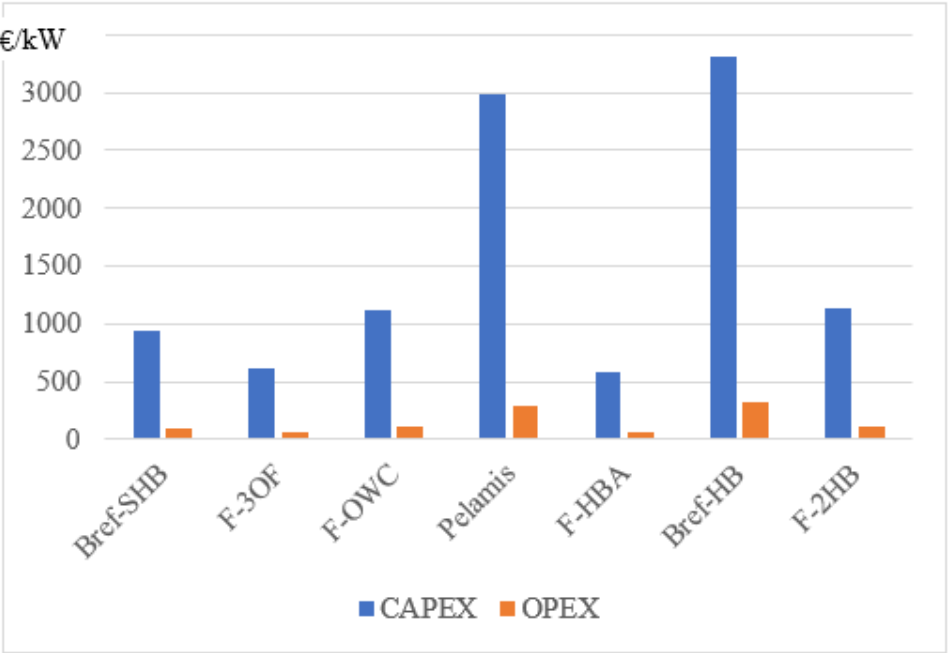
Figure 9. CAPEX per unit of case study located in the Norwegian Continental Shelf (Adapted with permission from Ref. [61]. 2019, Oliveira-Pinto, S., et al.).